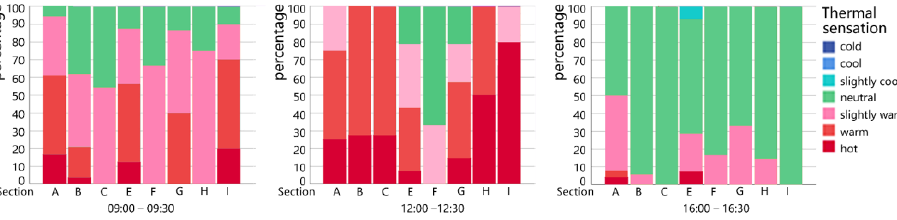
Figure A10. Thermal sensation votes of the three time periods on 12 September.